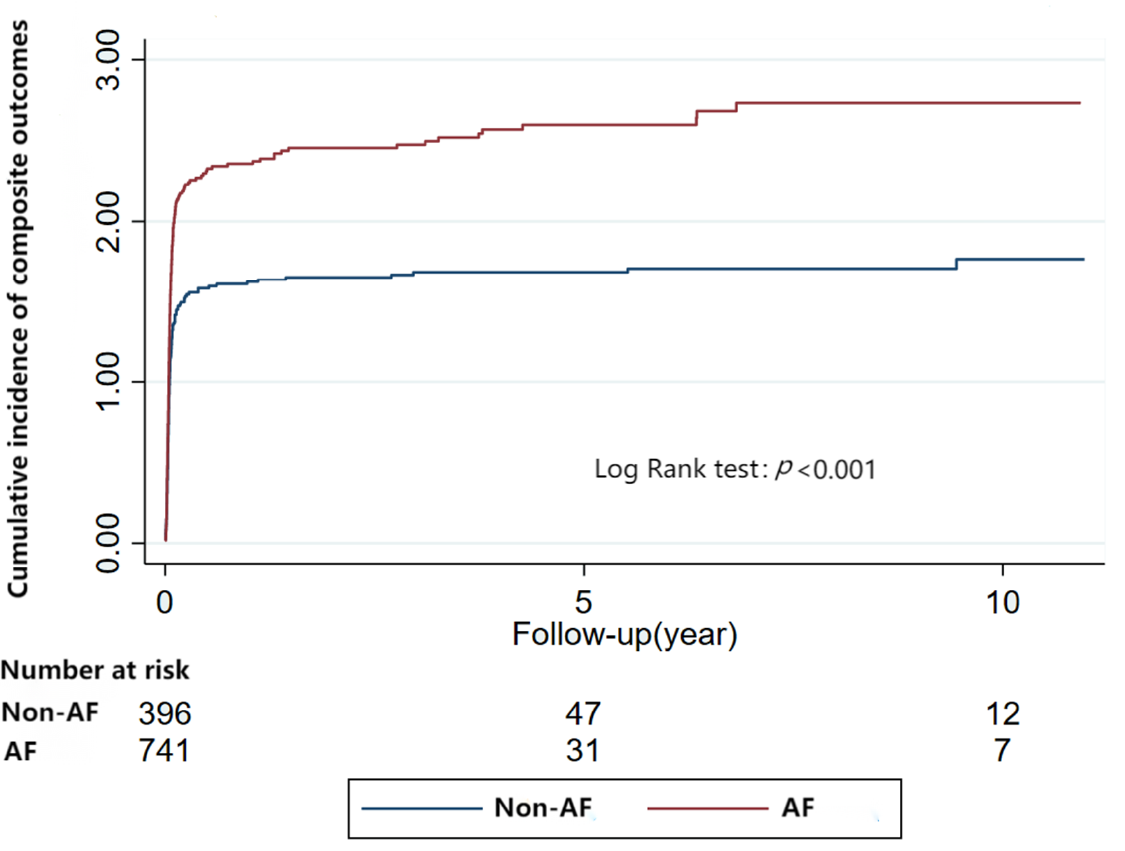
Figure 5. Relationship between atrial fibrillation and composite outcomes in restrictive cardiomyo- pathy (Kaplan-Meier Analyses).